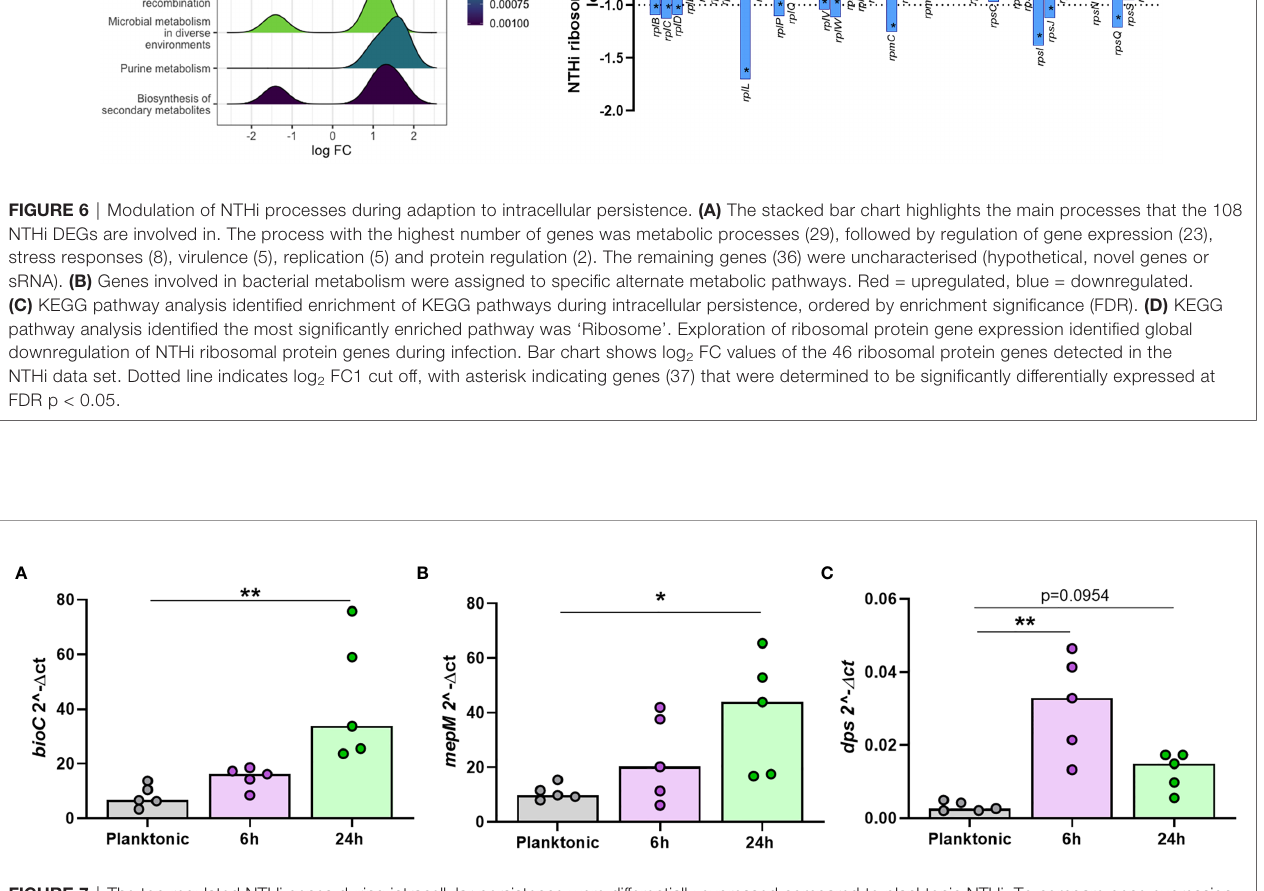
FIGURE 7 | The top regulated NTHi genes during intracellular persistence were differentially expressed compared to planktonic NTHi. To compare gene expression between planktonic and intracellular, persisting NTHi, RNA was harvested from NTHi ST14 grown in culture media alone (regarded as planktonic NTHi) or from NTHi- infected MDM at the 6 h and 24 h time points, as previously described (n = 5). The expression of the top regulated NTHi genes (A) bioC , (B) mepM and (C) dps was assessed by qPCR. Gene expression was normalised to NTHi rho gene. Graphs show unpaired data and lines indicate medians. N = 5. Data were analysed using a Kruskal-Wallis test with Dunn ’ s multiple comparisons; *p < 0.05, **p <